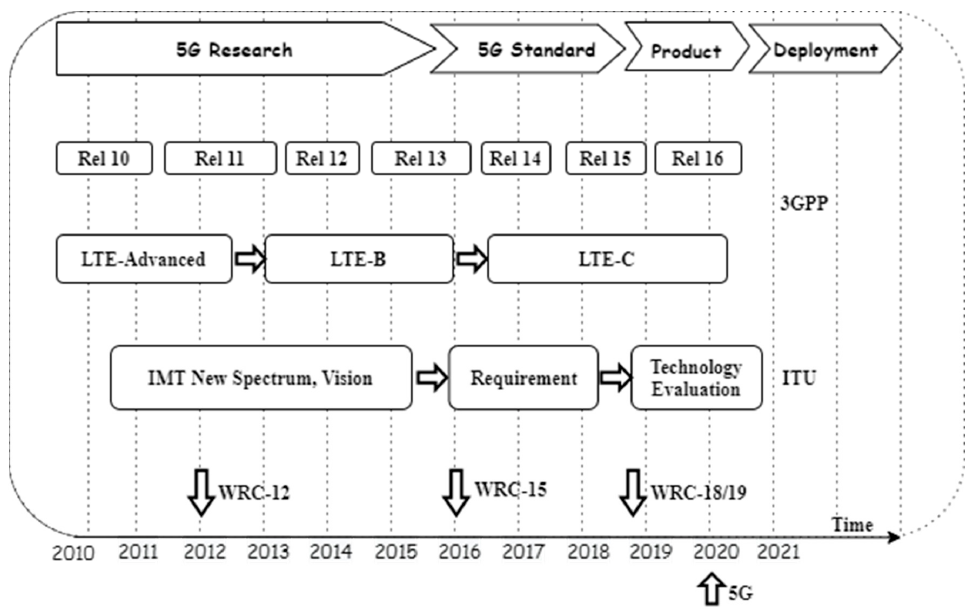
Figure 2. Plan execution timeline [7].